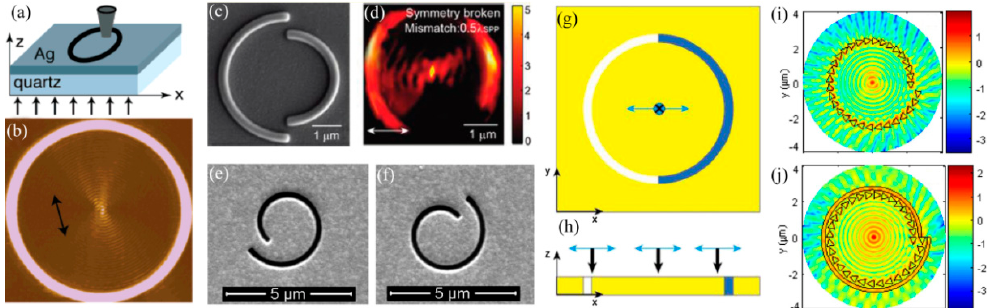
Figure 13. ( a ) Schematic structure of a circle cut into a 150 nm thick silver film; ( b ) Near-field pattern recorded by NSOM; ( c ) Symmetry broken plasmonic corral fabricated on the Au film; ( d ) | E z | 2 distributions under linearly polarized lasers; A ( e ) left- and ( f ) right-handed spiral plasmonic lens in gold film; ( g ) Schematic geometry of the semicircular slits on the Au film filled with different medium; ( h ) A cross section of this structure; ( i ) A spiral triangle array structure; ( j ) Alternating spiral triangle array and spiral slot lens. Reproduced from: (a,b), [69], Copyright © 2005, ACS; (c,d), [70], Copyright © 2011, ACS; (e,f), [71], Copyright © 2010, ACS; (g,h), [72], Copyright © 2014, Springer; (i,j), [73], Copyright © 2012, OSA.